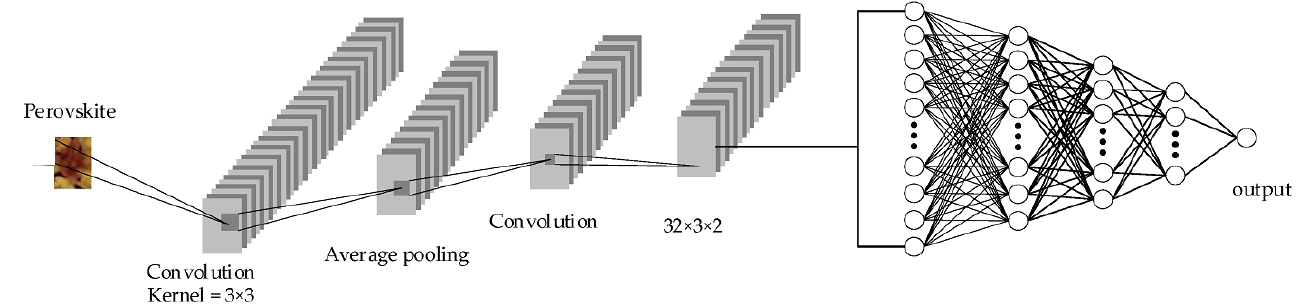
Figure 5. The CNN Figure 5. The CNN structure. Figure 5. The CNN structure.